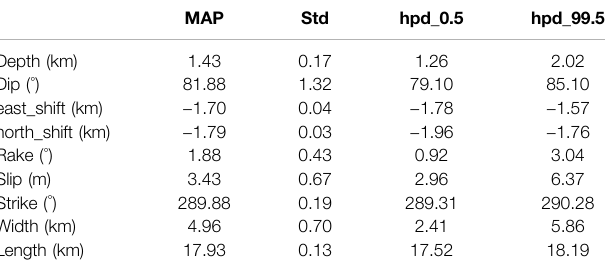
TABLE 3 | Fault geometry parameters of the Menyuan earthquake.